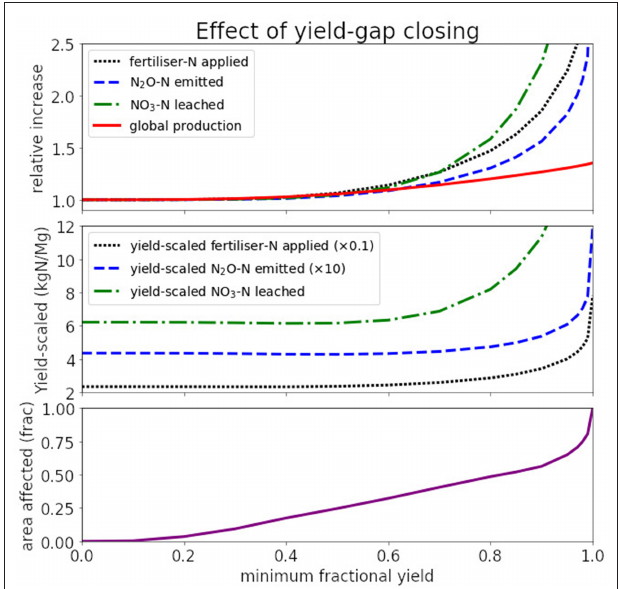
FIGURE 4 | Comparison between the “optimal” (blue, dashed lines) and “minimum fractional yield” (red, solid line) scenarios for closing yield gaps, showing the evolution of yield-scaled N-fertilizer usage and N losses as global maize production is increased. The yellow shaded region shows the space of possible yield-gap closing pathways. (Top) Yield-scaled (Y-S) N-fertilizer usage vs. global production. (Middle) Associated yield-scaled N 2 O-N emissions. (Bottom) Associated yield-scaled NO − 3 -N